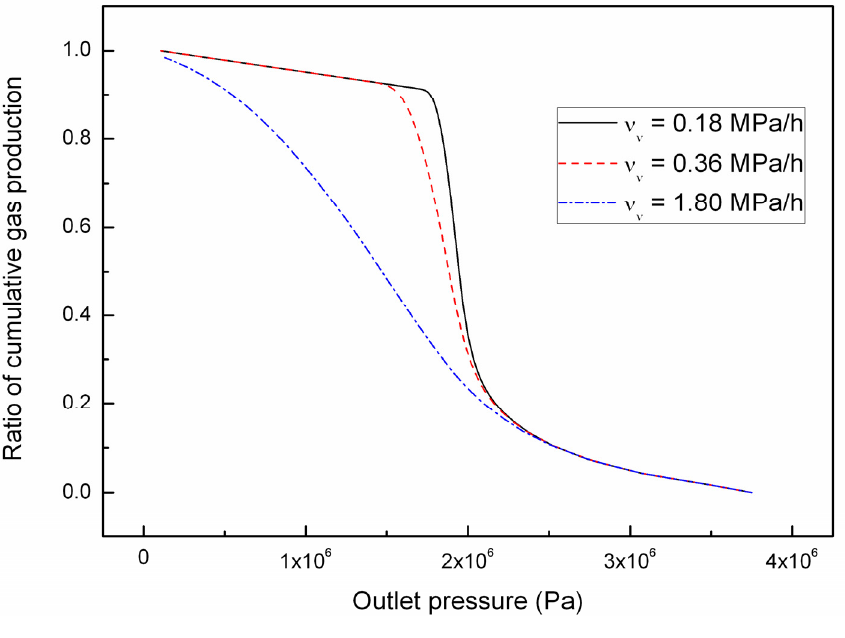
Figure 11. The relationships between the percentage of cumulative gas production and outlet pressure for the Class 2 of combined depressurization